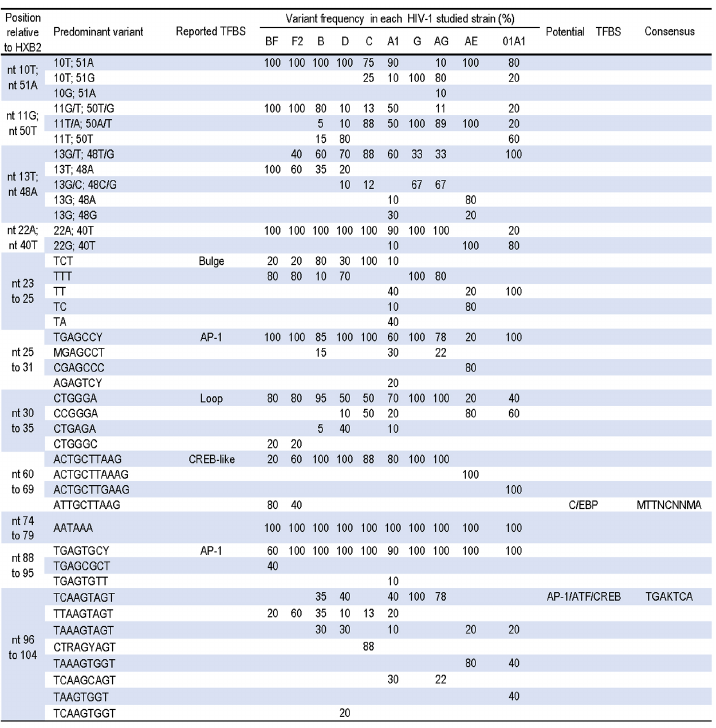
Fig 3. Variability in the R region of diverse HIV-1 subtypes and CRFs. N = any base; W = A or T; R = A or G; Y = C or T; K = G or T; M = A or C; S = G or C; D = A, G or T; H = A, C or T; B = C, G or T.